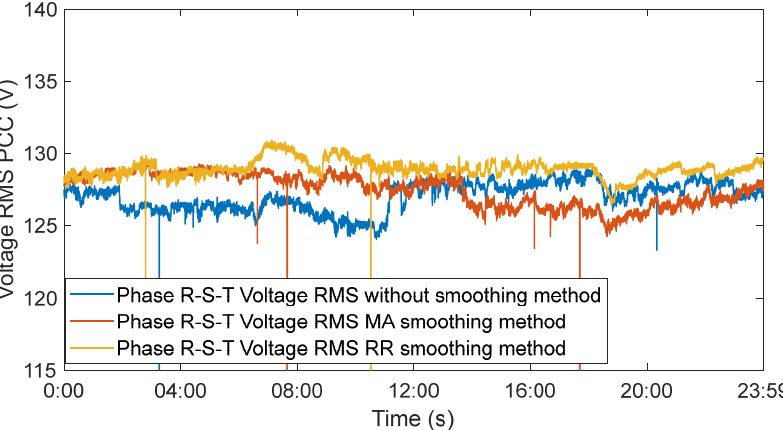
Figure 20. Voltage in alternating current bar, result when applying the proposed power smoothing methods, time window one day, resolution: hourly average data.